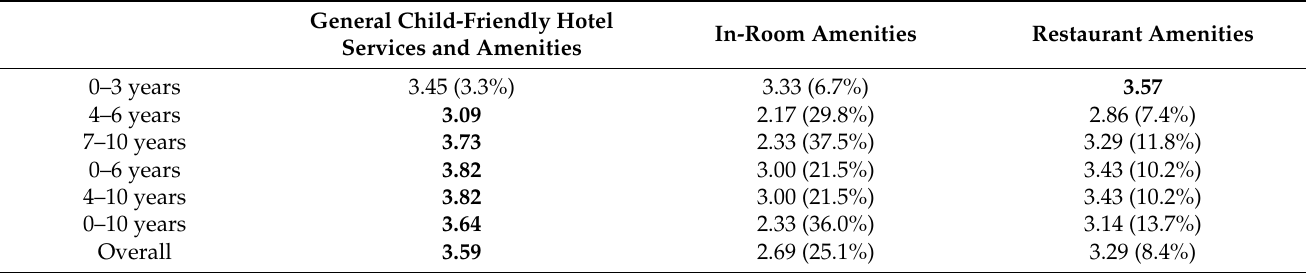
Table 2. Ranking of hotel amenities based on the opinions of parents with children of different ages.